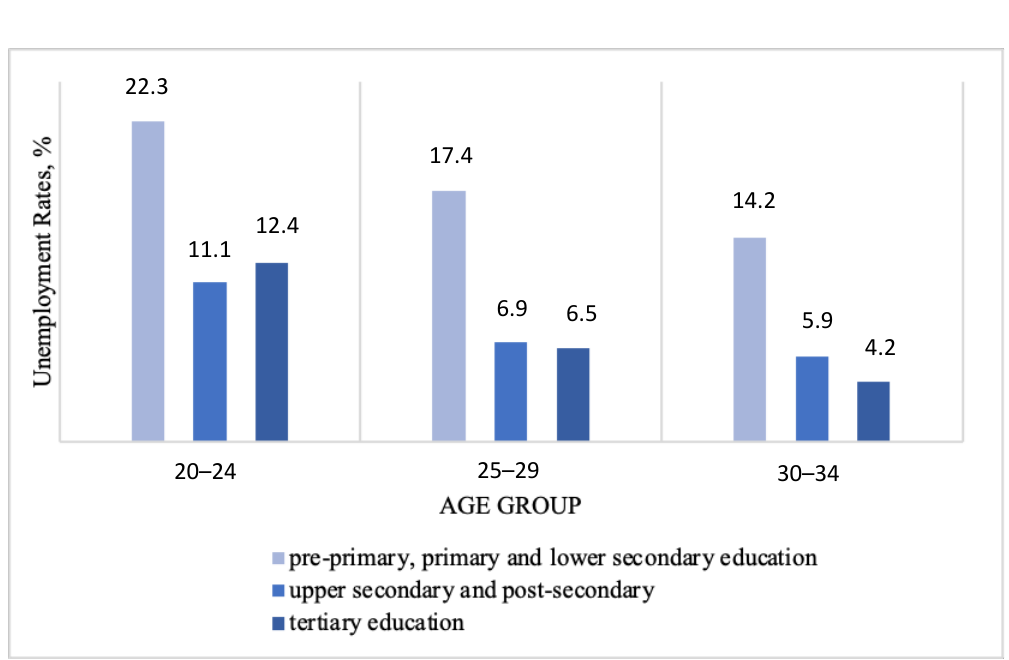
Fig. 1. Unemployment rates by age and educational attainment level in the EU, 2019.